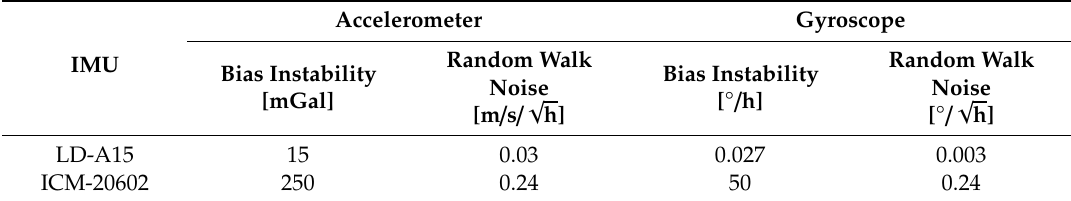
Figure 5. Testing platform. ( a ) GNSS, IMU and LiDAR ( b ) Odometer. Table 1. Specifications of the LD-A15 and